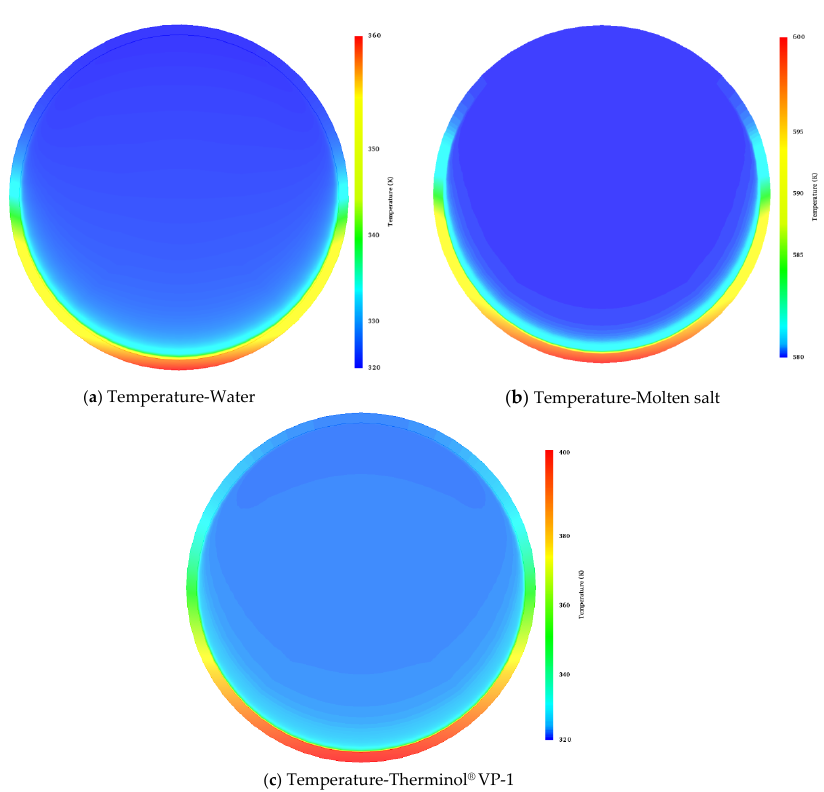
Figure 13. Temperature contours of all fluids at the smallest inlet temperatures.